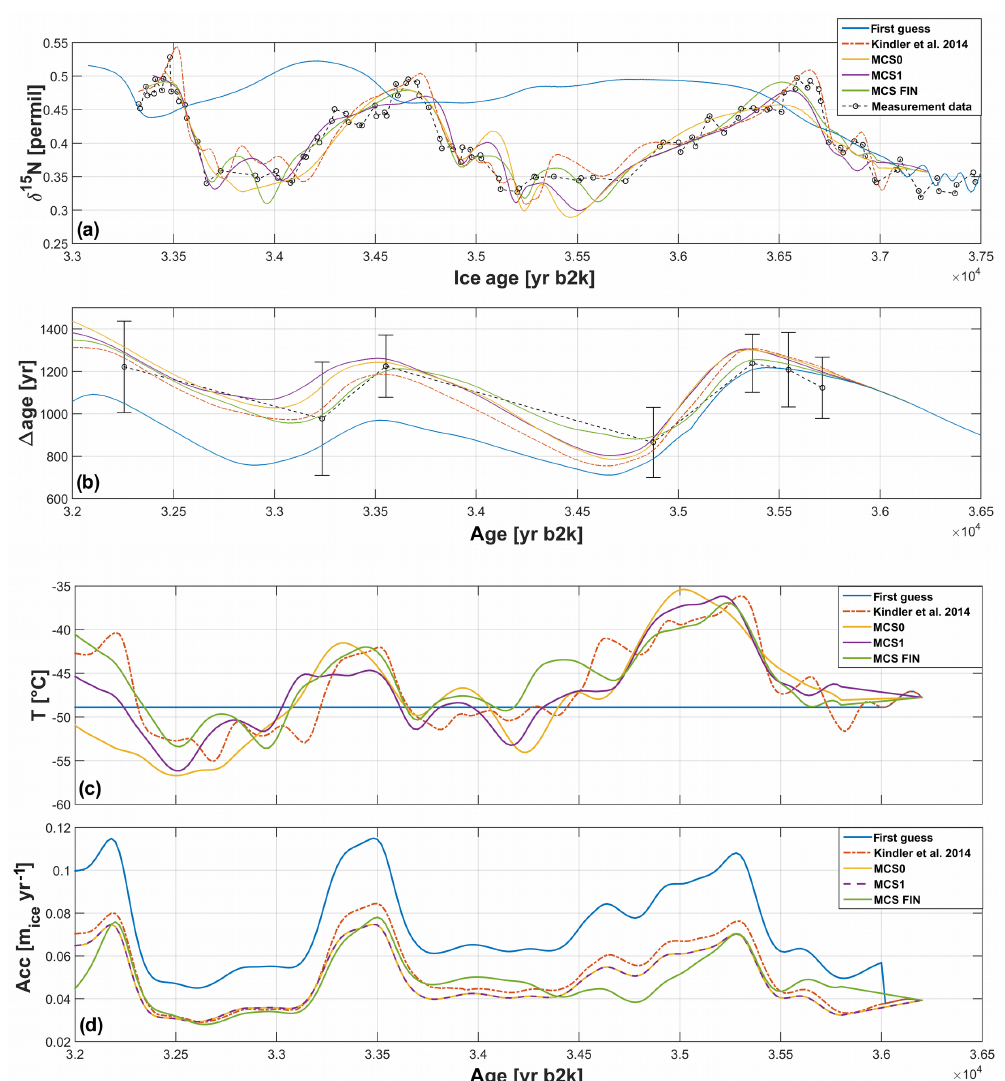
Figure 11. Proof of concept for glacial reconstructions (NGRIP DO6 and DO7): (a) δ 15 N target plot: δ 15 N model output for the first-guess input (blue line), Kindler et al. (2014) fit (orange dotted line), Monte Carlo solution 0 (MCS0, yellow line), Monte Carlo solution 1 (MCS1, purple line), final Monte Carlo solution (MCS FIN, green line) and δ 15 N measurement target (black dotted line, measurement points are black cycles, data from Kindler et al., 2014). (b) (cid:49) age target plot: (cid:49) age model output for the first-guess input (blue line), Kindler et al. (2014) fit (orange dotted line), Monte Carlo solution 0 (MCS0, yellow line), Monte Carlo solution 1 (MCS1, purple line), final Monte Carlo solution (MCS FIN, green line) and (cid:49) age measurement target (black dotted line, measurement points are black cycles, data from Guillevic, 2013). (c) Temperature solution plot: first-guess input (blue line), Kindler et al. (2014) solution (orange dotted line), Monte Carlo solution 0 (MCS0, yellow line), Monte Carlo solution 1 (MCS1, purple line) and final Monte Carlo solution (MCS FIN, green line). (d) Accumulation-rate solution plot: first-guess input (blue line), Kindler et al. (2014) solution (orange dotted line), Monte Carlo solution 0 (MCS0, yellow line), Monte Carlo solution 1 (MCS1, purple line) and final Monte Carlo solution (MCS FIN, green